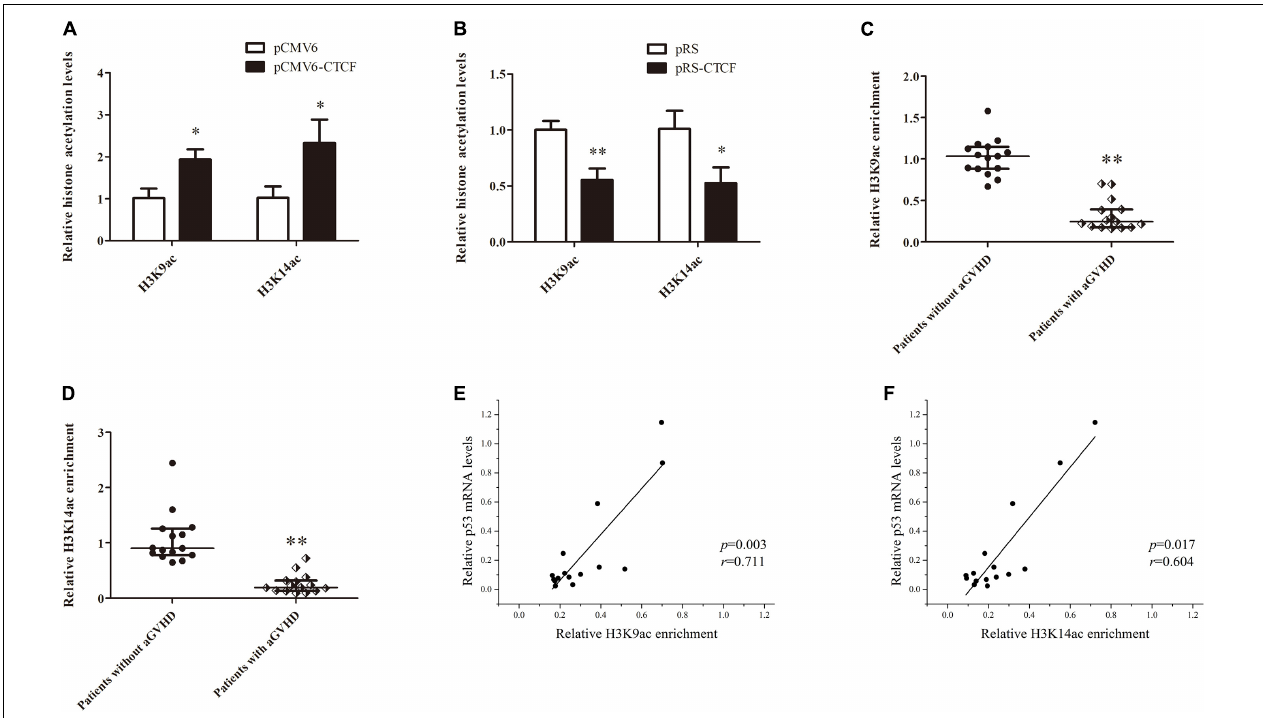
FIGURE 5 | CTCF alters histone H3K9ac and H3K14ac levels in the p53 promoter. (A,B) ChIP-qPCR analysis of the enrichment of histone H3K9ac and H3K14ac levels in the p53 promoter region in normal CD4 + T cells transfected with pCMV6-CTCF (A) or pRS-CTCF (B) . Values are relative to those obtained with input DNA prepared from untreated chromatin. Data are mean ± SD from three independent experiments. (C,D) ChIP-qPCR analysis of the enrichment of histone H3K9ac (C) and H3K14ac (D) levels in the p53 promoter region in CD4 + T cells from patients with aGVHD ( n = 15) and individuals without aGVHD ( n = 15). Values are relative to those obtained with input DNA prepared from untreated chromatin. (E , F) Correlation analysis of H3K9ac (E) /H3K14ac (F) of p53 promoter and p53 expression in aGVHD CD4 + T cells ( n = 15). ∗ P < 0.05, ∗∗ P <